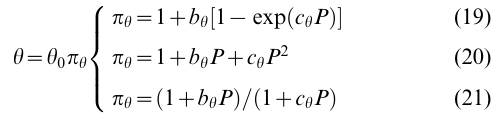
Table 1. A possible systematics on the modifications of the response to an effector.